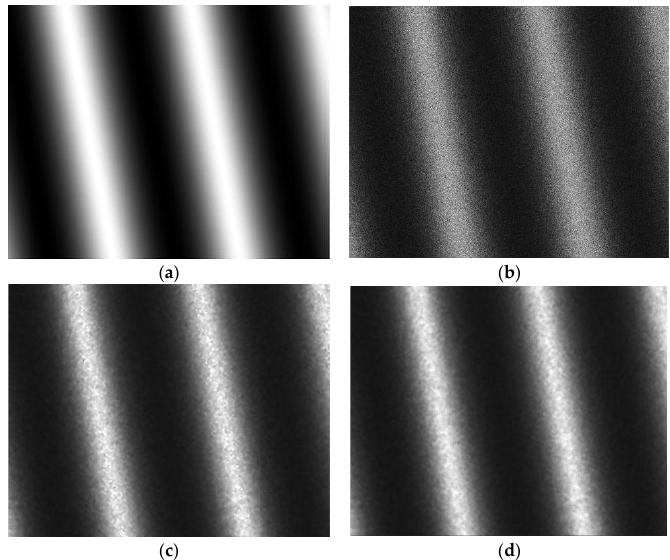
Figure 7. Simulated synthetic aperture radar (SAR) image ( a ) speckle-free (Cx = 0.831) and ( b ) with Rayleigh-distributed speckle in presence of a sinusoidal digital elevation model (DEM) (Cx = 1.543). Despeckled image ( c ) using SB-PPB (Cx = 0.835, RT = 359 s), ( d ) PPB with four iterations (Cx = 0.835, RT = 636 s).